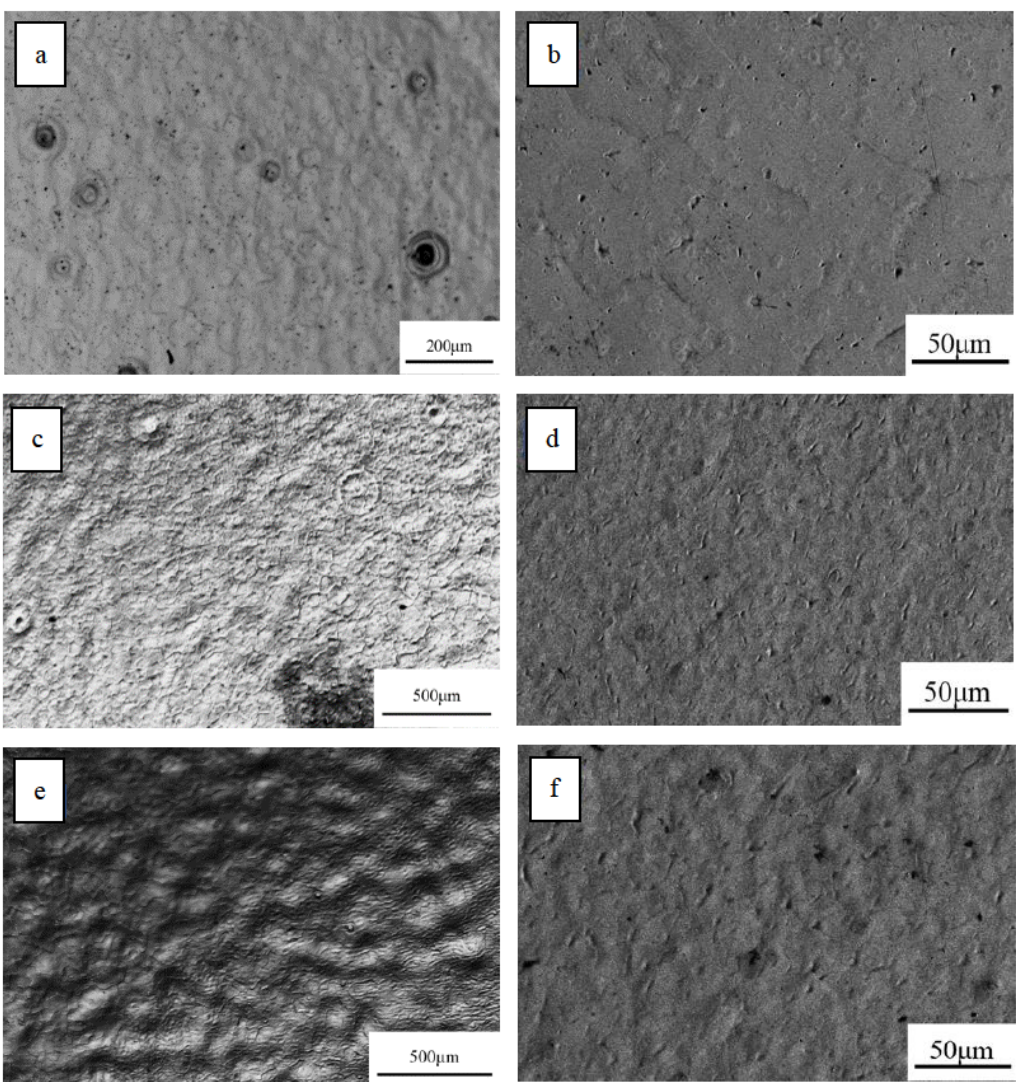
Figure 5: SEM images of Zr-17Nb (ST) sample without HCPEB treatment (a) crater structures, 5 pulses, low magnification; (b) partial enlarged image of Figure 5(a), 5 pulses, high magnification;(c) partial remelting of crater structures, 15 pulses, low magnification; (d) Surface defects, 15 pulses, high magnification; (e) surface microstructure, 30 pulses, low magnification; (f) surface defects, 30 pulses, high